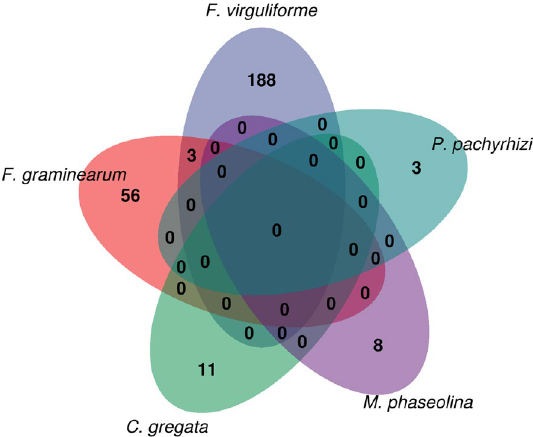
Figure 2. Venn diagram of prioritized candidate resistance genes against each species. The diagram demonstrates a high species-specific response to each pathogen, as genes are mostly not shared. Only three genes are shared between F. graminearum and F. virguliforme , suggesting some conservation at the genus